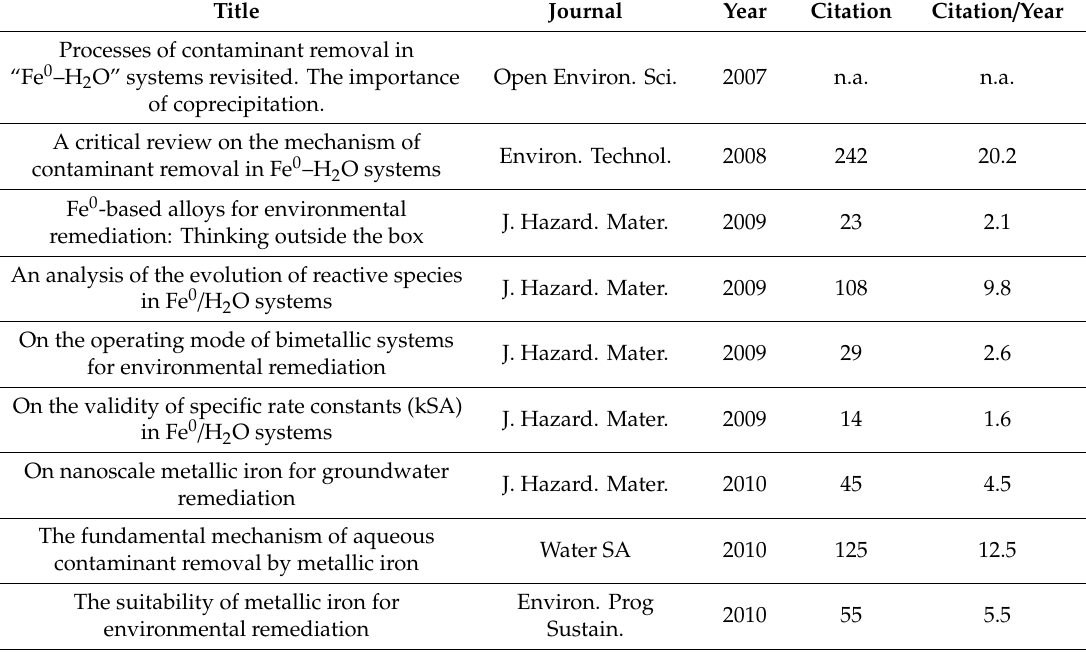
Table 2. Selected articles disproving the reductive transformation concept for the Fe 0 / H 2 O system and their current bibliometry according to Scopus and ScienceDirect (www.scopus.com: 23 / 03 / 2020). Self-citation is included. It is seen that the best citation rate is 20 per year in a context where more than 500 articles are produced every